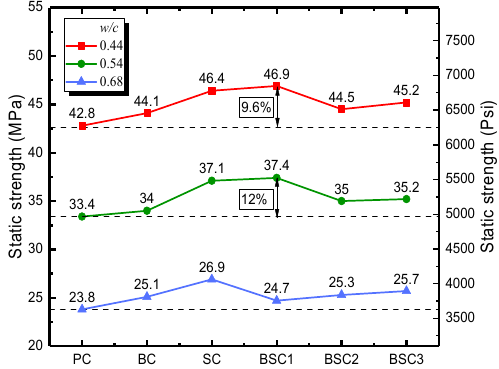
Figure 8. The 28-day compressive strength of BSFRC.